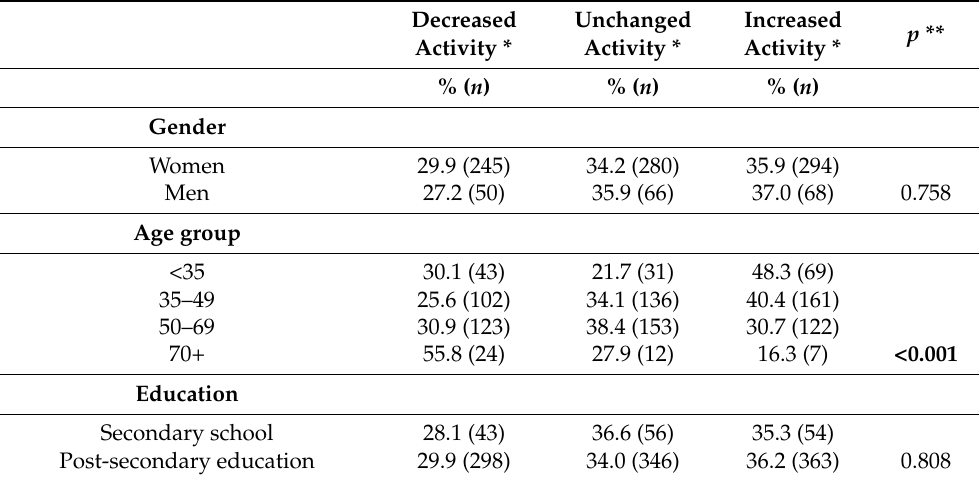
Table 3. Proportion of participants reporting decreased, increased, or unchanged physical activity in different groups based on gender, age, family situation, geographical area, type of village, and country of